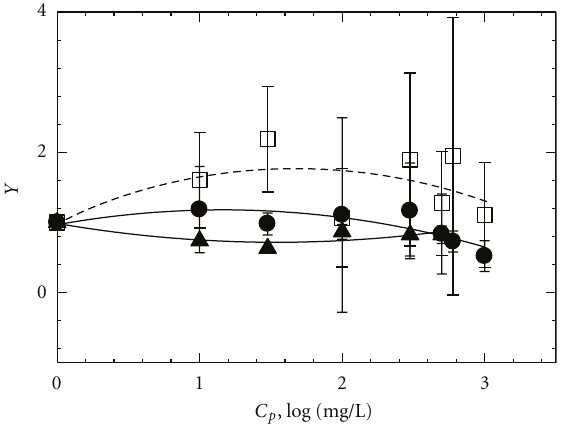
Figure 2: Normalized specific chlorophyll a ( Y ) as a function of the concentration of the NP. Solid circles are Al 2 O 3 (17.6 nm). Open squares are SiO 2 (14.3nm). Solid triangles are TiO 2 (18.7 nm). Error bars are ± 1 standard deviation ( n ≥ 3). Lines are 2nd-order polynomial fits to the data. The data was fitted with an empirical 2nd-order polynomial from SigmaPlot ver. 9.01. Experimental conditions: initial algae concentration = 1 . 4 ± 0 . 9 × 10 6 cell/mL, test duration = 4 days, and initial test volume = 200mL.